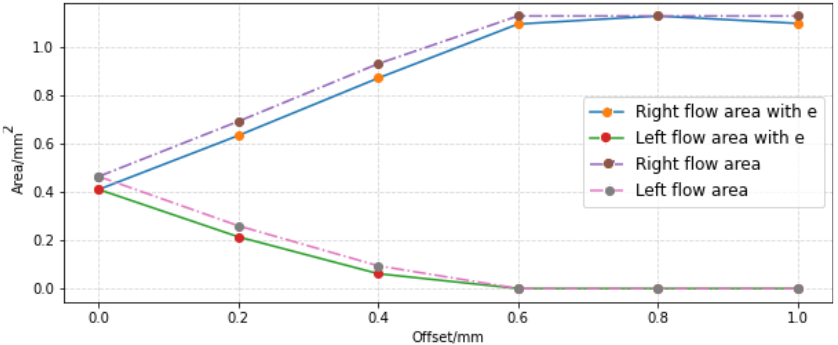
Figure 16. Variation curve of flow area with offset.